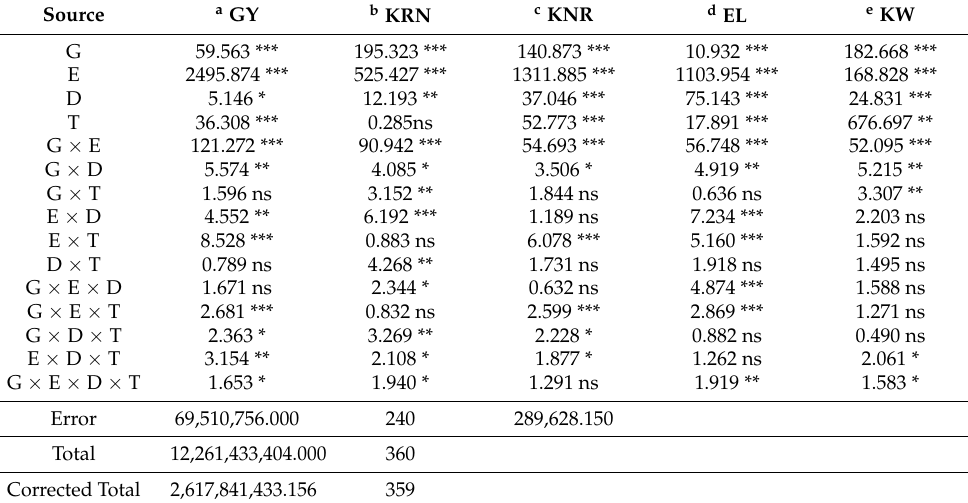
Table 3. Estimation of factor contribution to grain yield, kernel rows number, kernel number per rows, ear length, 1000-kernel weight